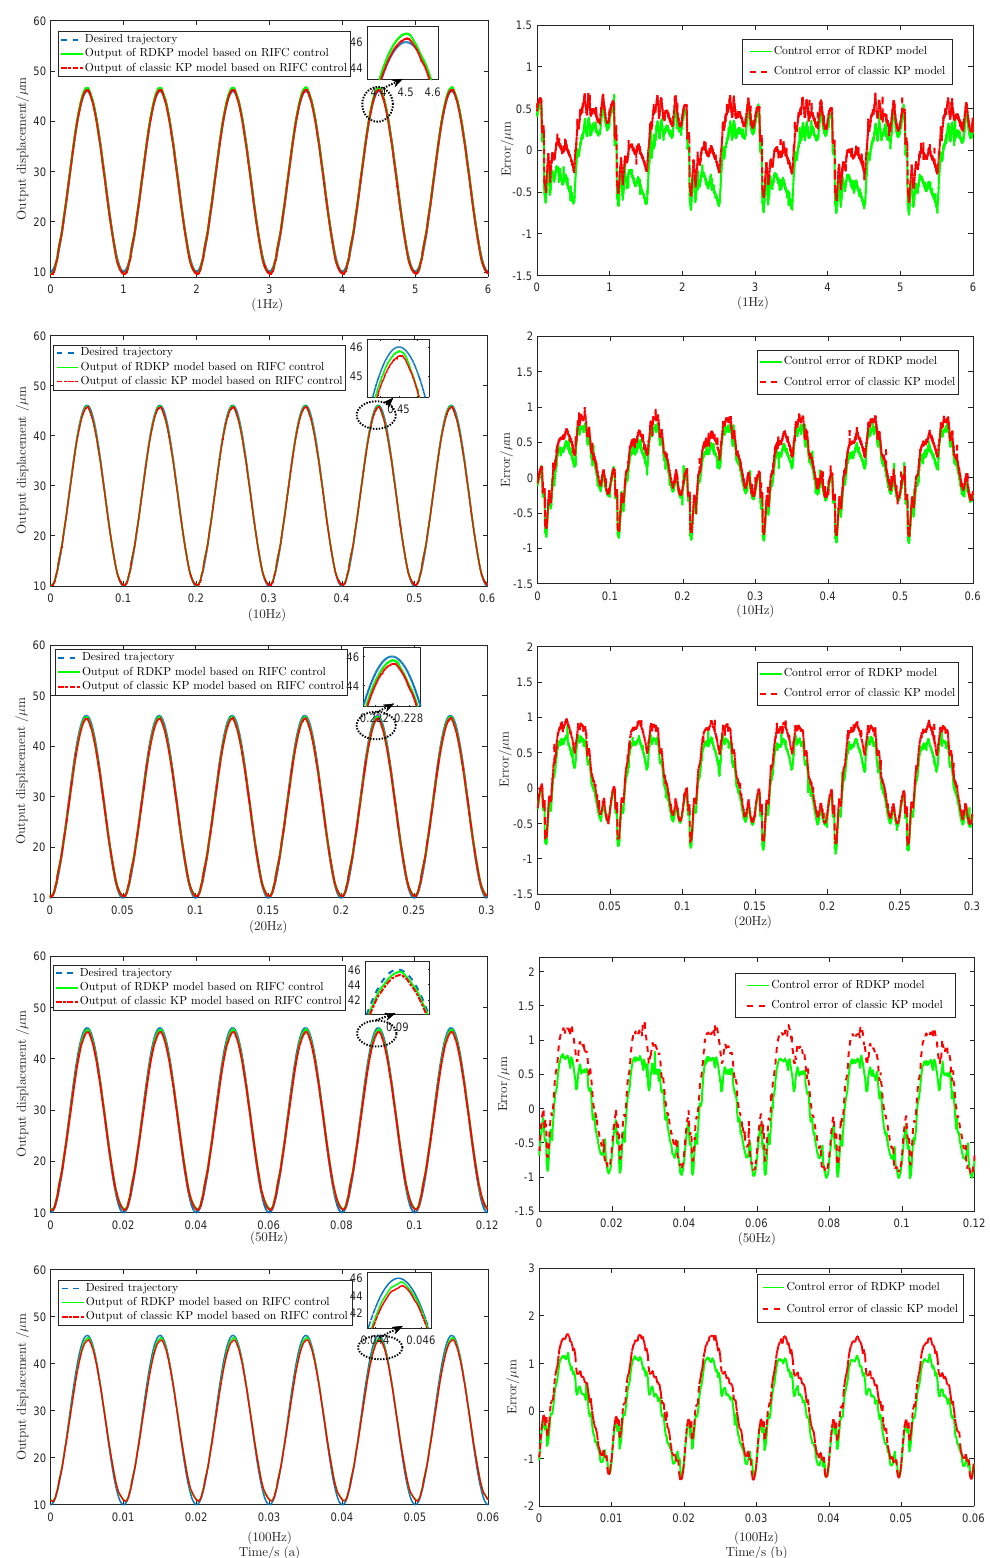
Figure 12. The tracking performance of the RDKP model and classic KP model based on recursive inverse feed-forward compensation (RIFC) control with diverse input voltage frequency, including ( a ) the desired and control output tracking displacements ( b ) control errors of the proposed RDKP model and classic KP